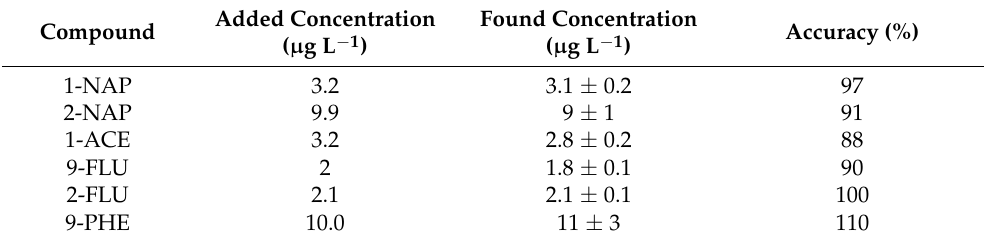
Table 6. Mean accuracy values (%) obtained for four different spiked urine samples. Added Concentration Found Concentration Accuracy (%) Compound ( µ g L − 1 ) ( µ g L − 1 ) 1-NAP 3.2